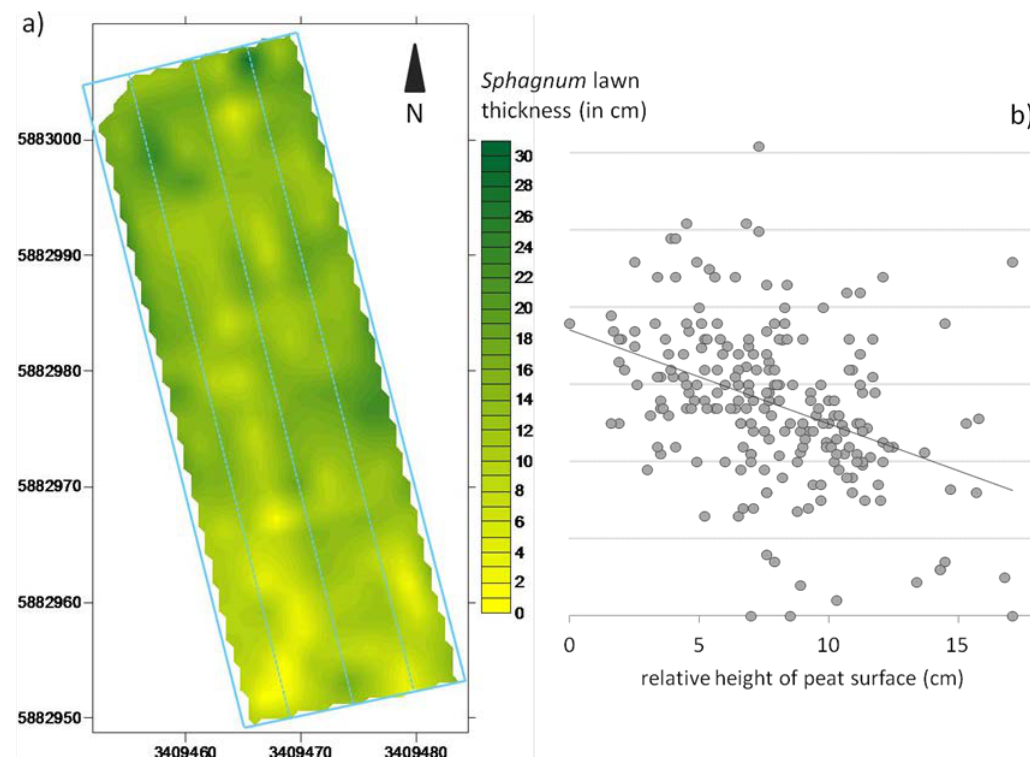
Figure 10. a) Sphagnum papillosum lawn thickness (cm) at the study site 6.5 years after installation, measured at points on a 2.5 m grid. Blue lines represent the irrigation system with ditches (solid lines) and subsurface pipes (dotted lines). b) Relationship between Sphagnum lawn thickness and relative height of the peat surface (cm above the lowest peat surface altitude) (P < 0.001, r =